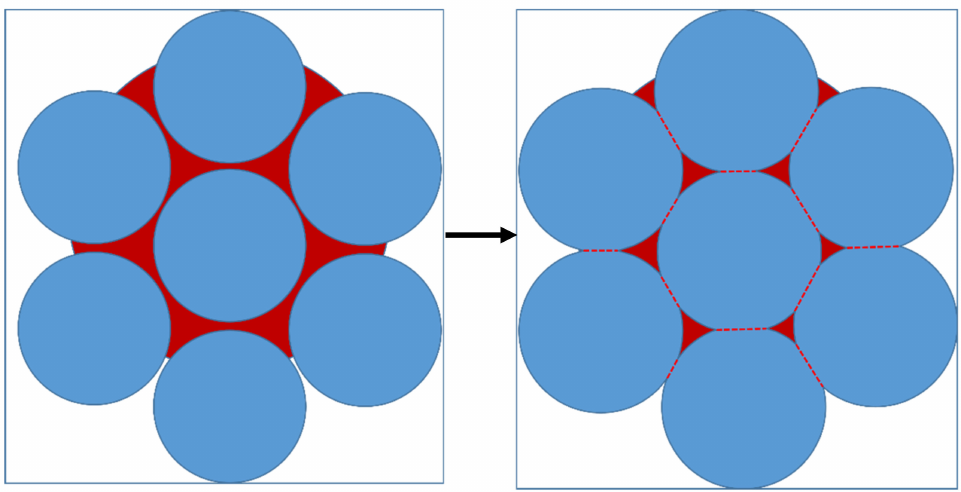
Figure 10. The evolution of liquid phase sintering.